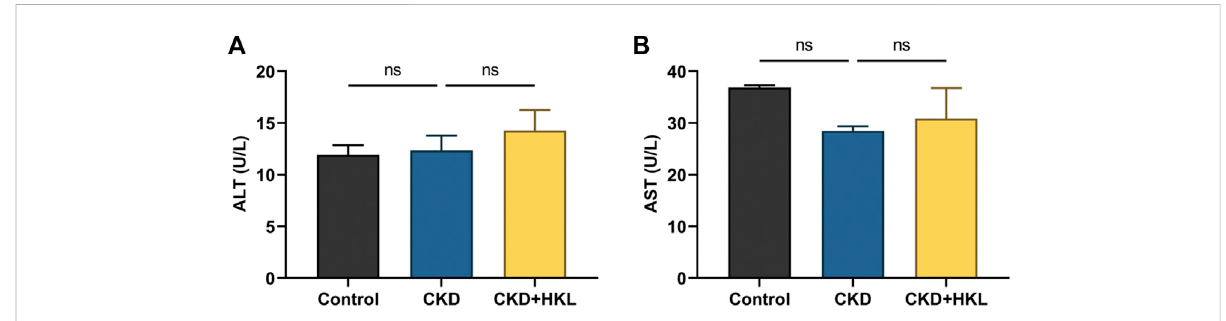
FIGURE 2 Effects of HKL on liver function indexes. (A) Alanine transaminase levels. (B) Aspartate transaminase levels. Data are expressed as mean ± SEM, n = 6 rats per group, ns = no signi fi cance.